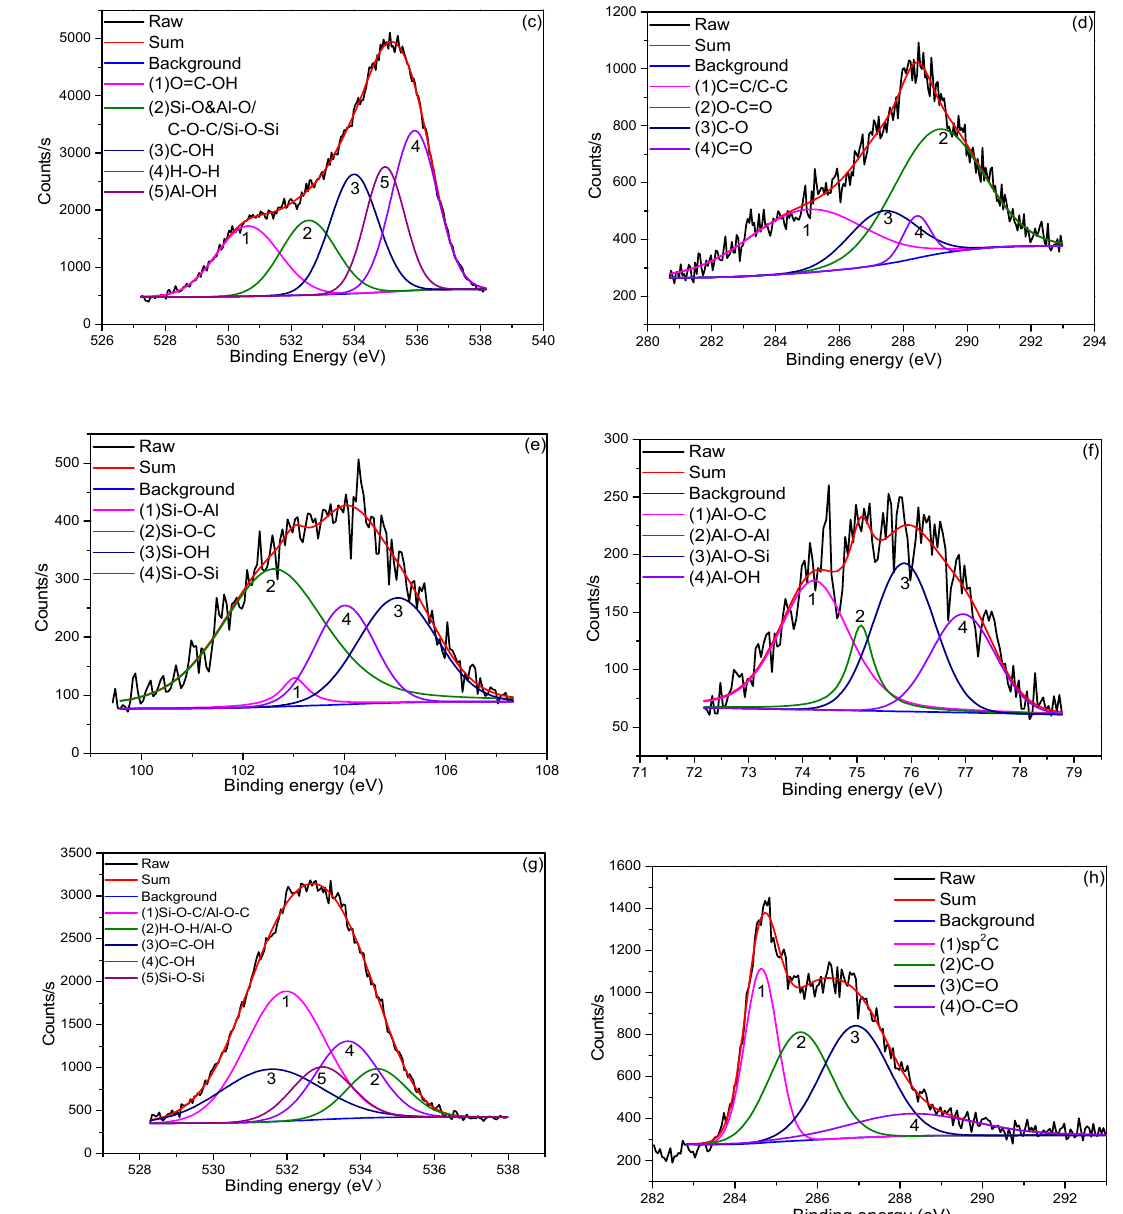
Figure 2. High resolution XPS data for specimens before sintering ( a ) Si2p, ( b ) Al2p, ( c ) O1s, ( d ) C1s and after sintering ( e ) Si2p ( f ) Al2p ( g ) O1s ( h ) C1s.